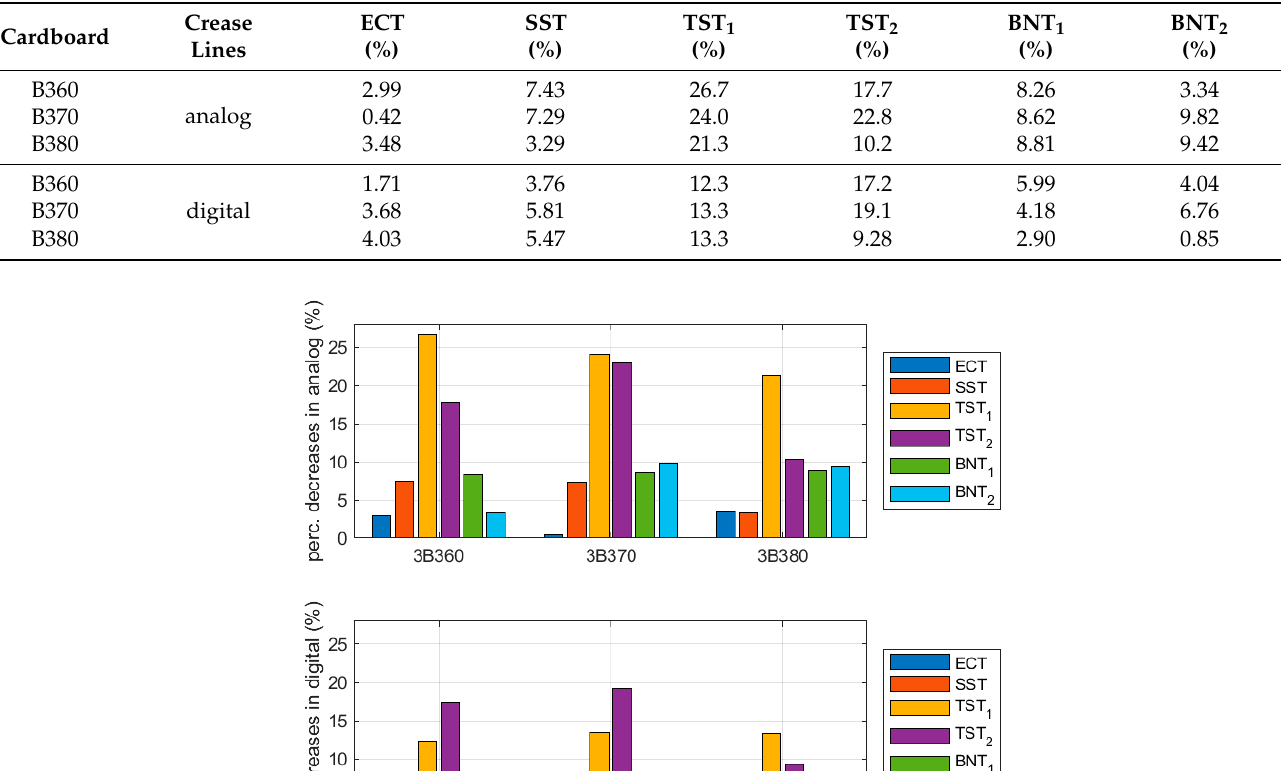
Figure 8. Bending stiffness test results from six samples of B370 corrugated board for each produc- tion technology: ( a ) analog and ( b ) digital crease lines. Table 3. Percentage differences between results for crease-free region samples and samples with a crease along the sample length.